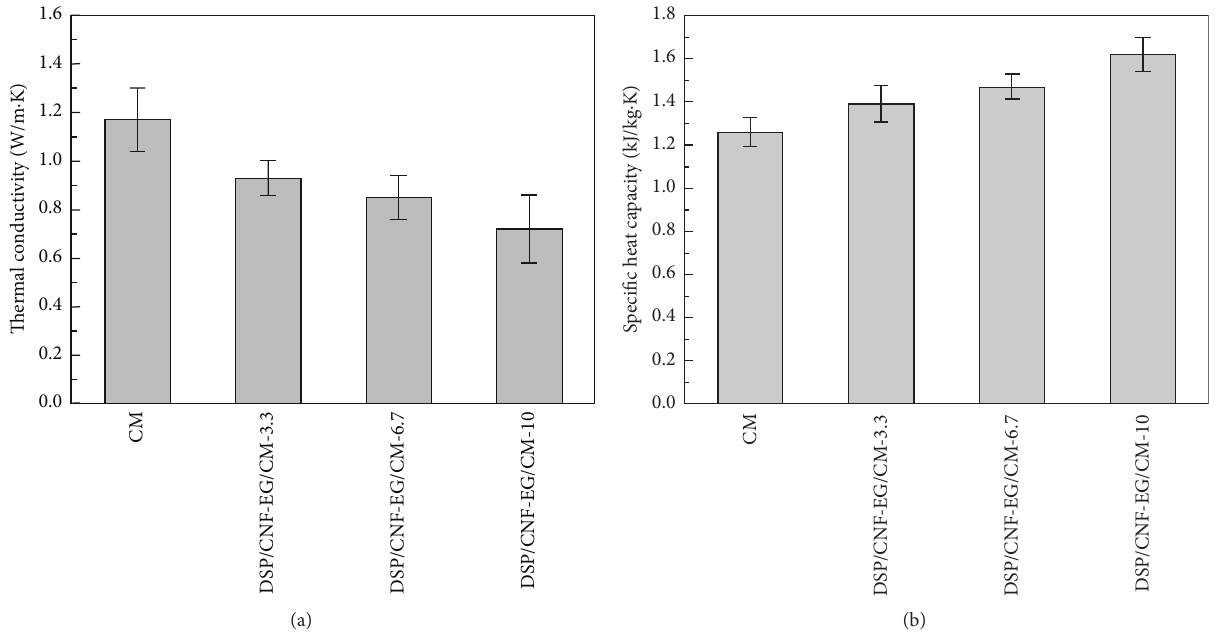
Figure 6: Thermal conductivity (a) and specific heat capacity (b) of CM and DSP/CNF-EG/CM samples.